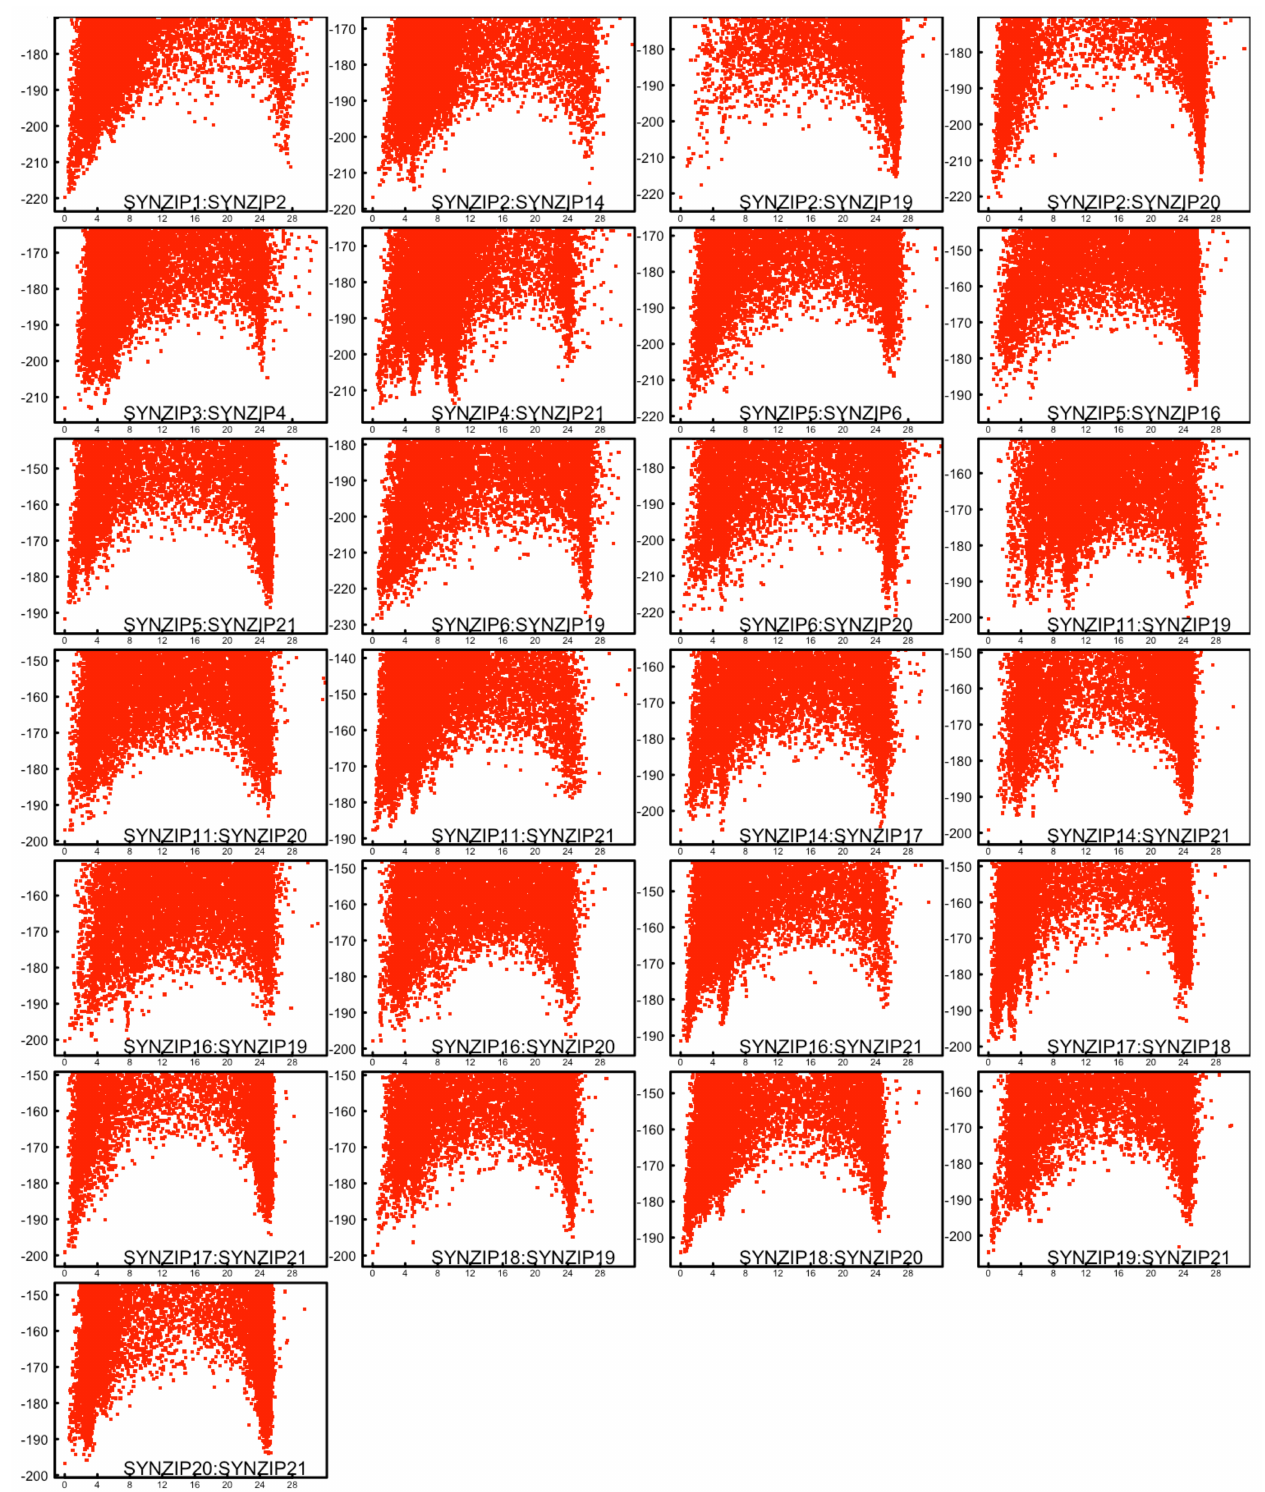
Figure 1. Folding funnels for highest affinity SYNZIP dimers. In each plot, the energy for the final folded structure from Rosetta fold’n’dock sampling was plotted as a function of root mean square deviation (RMSD) from the lowest energy model (calculated in Ångström over corresponding C α atoms). In total, 20,000 folding trajectories were simulated, thus the plots show energy vs. RMSD for 20,000 structures. Out of the 25 energy landscapes for the highest affinity dimers, almost all pairs show well defined folding funnels, except for SYNZIP4:SYNZIP21 and SYNZIP11:SYNZIP19